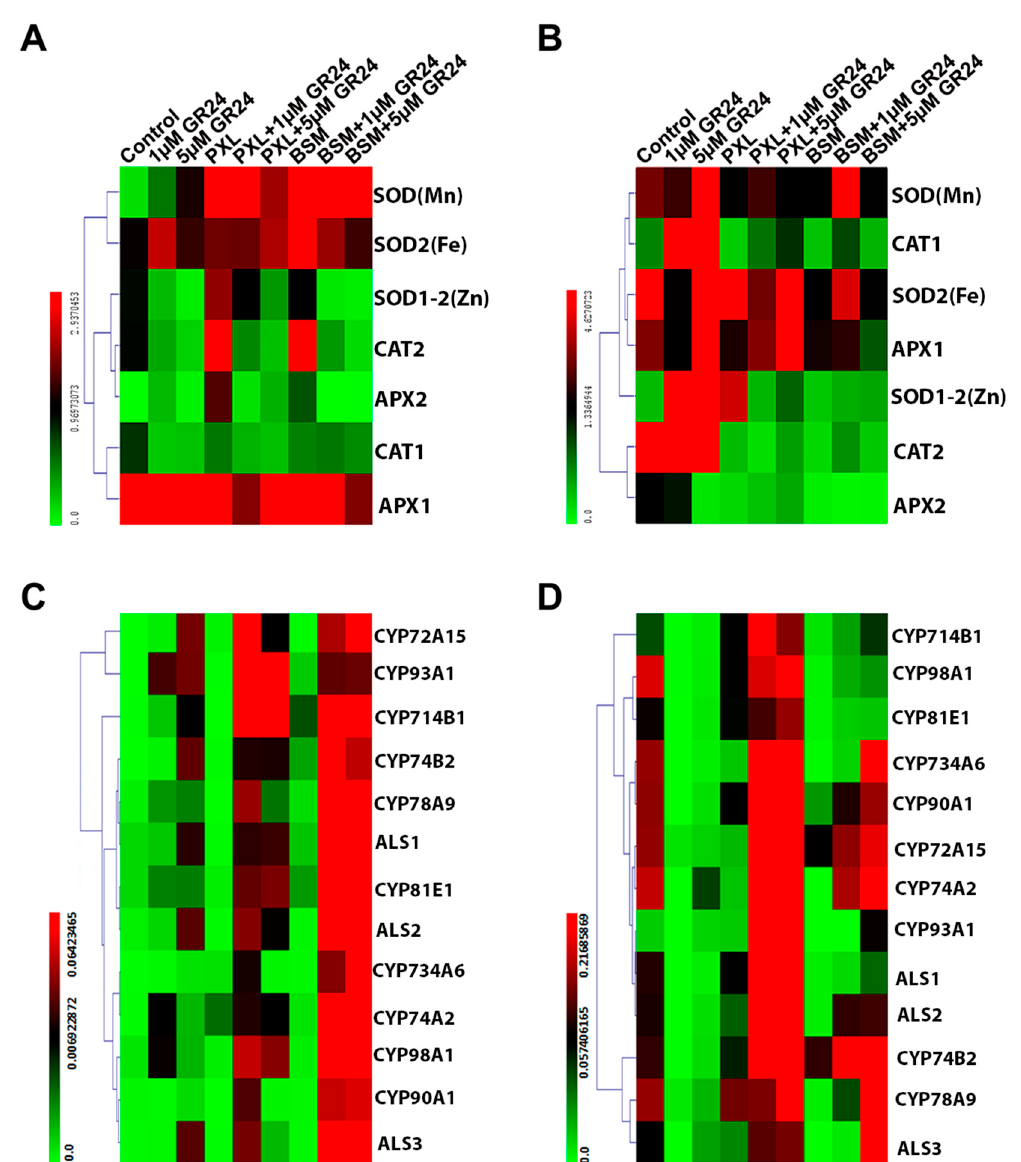
Figure 6. Effect of SL on the expression level of antioxidant-related, CYP, and ALS genes under herbicide stresses after 4 days of treatments. The expression level of ( A , B ) antioxidant-related genes and ( C , D ) CYP and ALS genes in roots and leaves, respectively, under different treatments for three days.